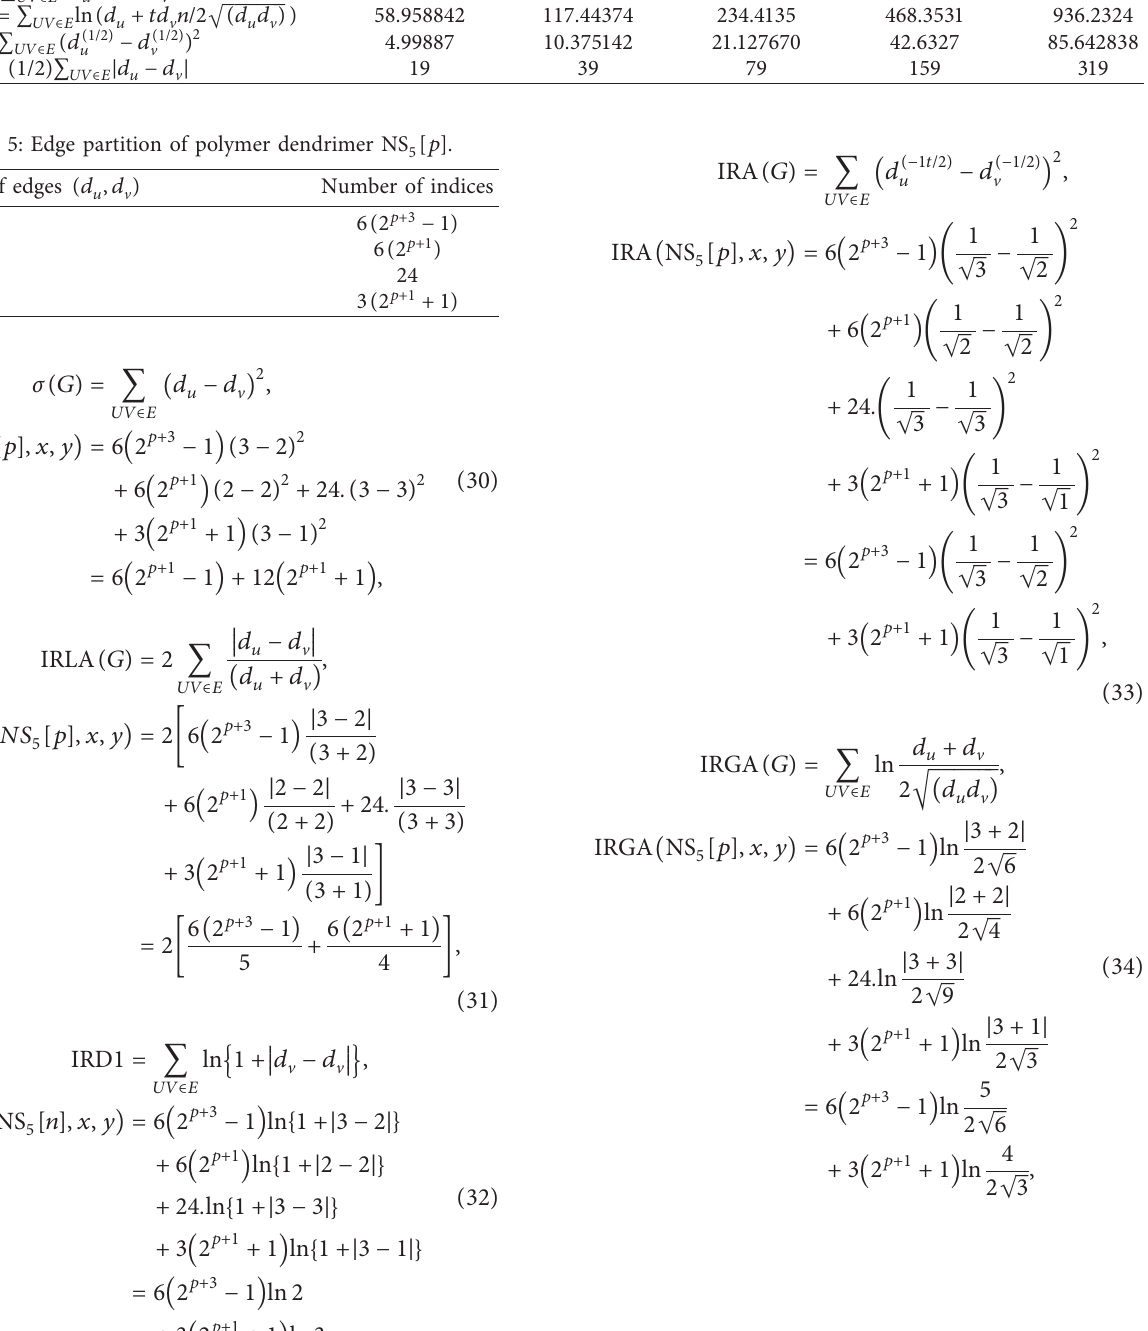
Table 4: Irregularity indices for fullerene dendrimer NS